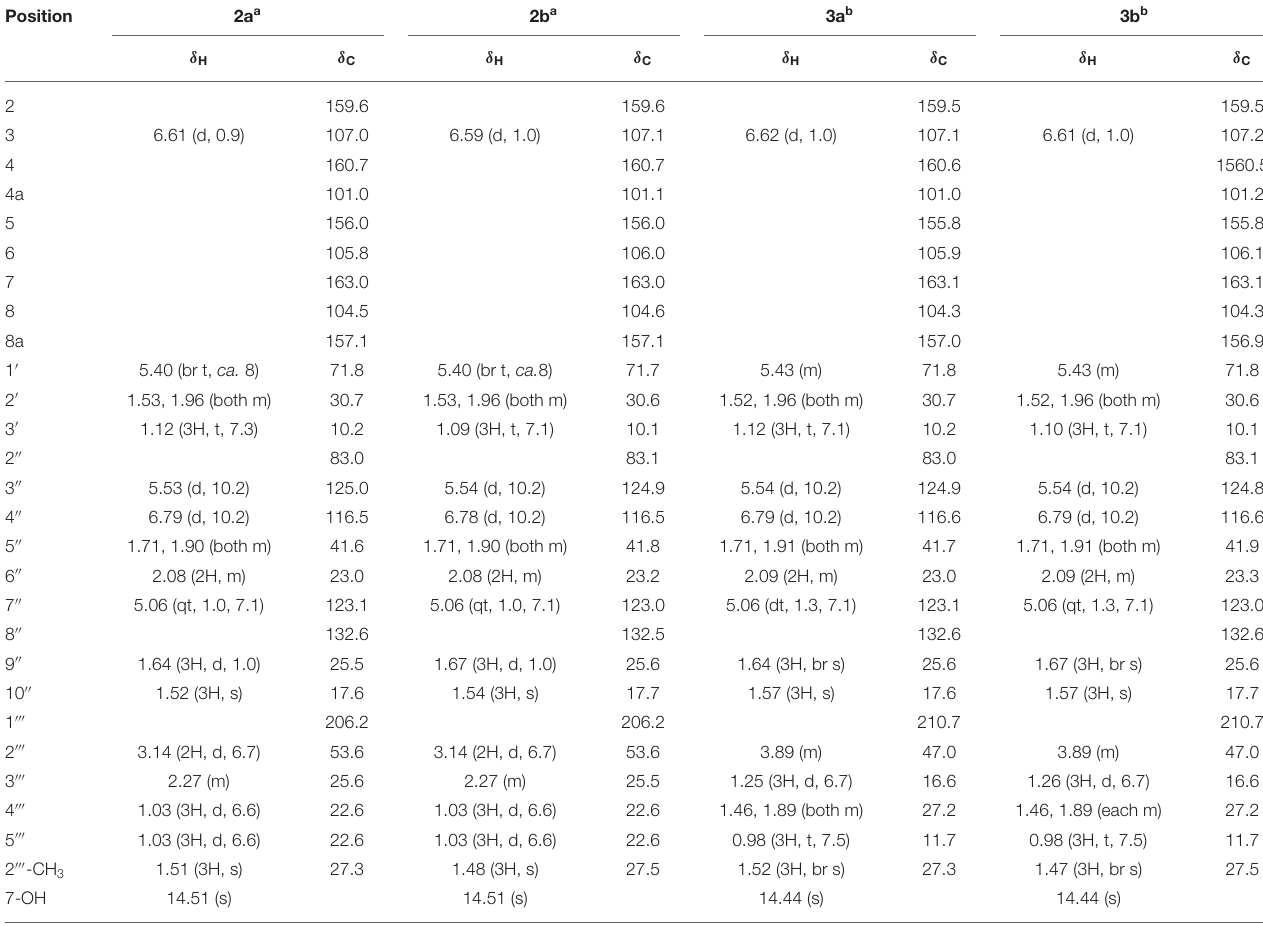
TABLE 2 | 1 H and 13 C NMR spectroscopic data (CDCl 3 ) for mammeasins E ( 2 ) and F ( 3